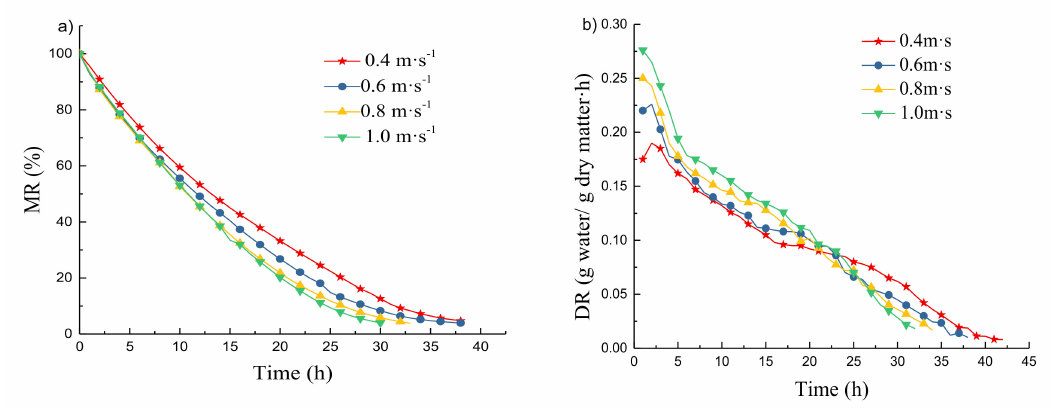
Figure 6. Variations of the moisture ratio ( a ) and drying rate ( b ) with drying time at a di ff erent velocity of drying